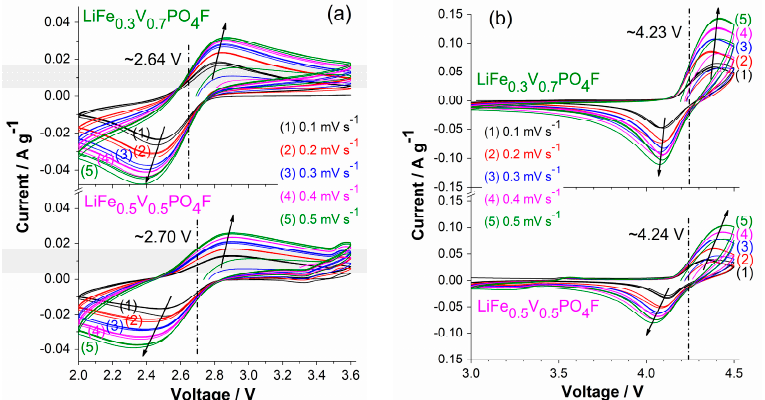
( c ). With the exception of the starting half cycle, all of peak positions are from the second cycle.